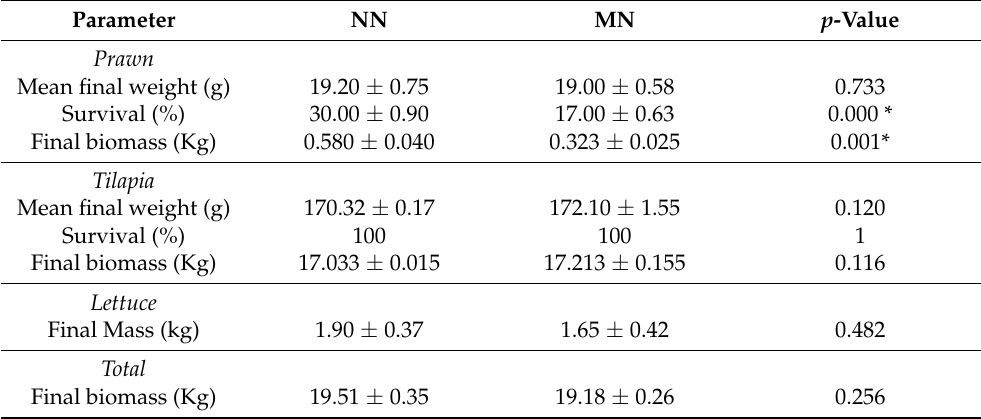
Table 2. Performance in an integrated giant freshwater prawn ( Macrobranchium rosenbergii ), tilapia ( Oreochromis niloticus ), and lettuce ( Lactuca sativa L) system (n = 3). Parameter